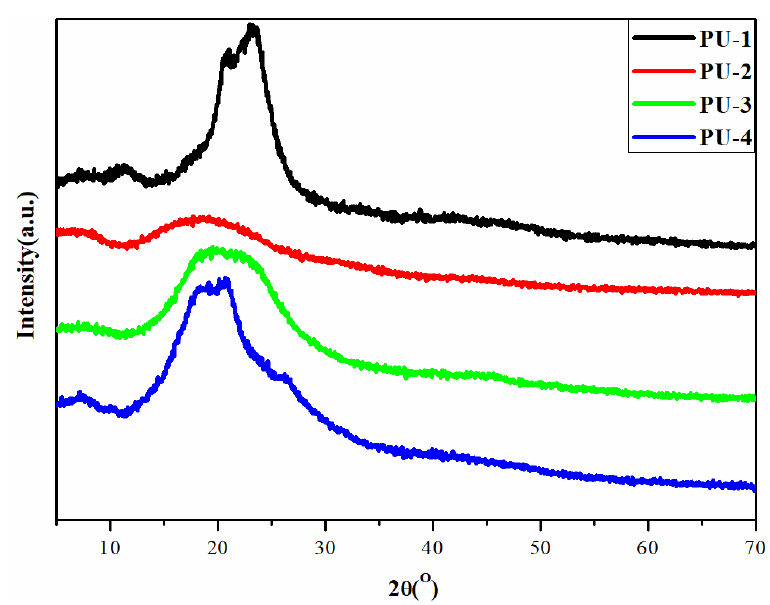
Figure 9. XRD curves of PUs.